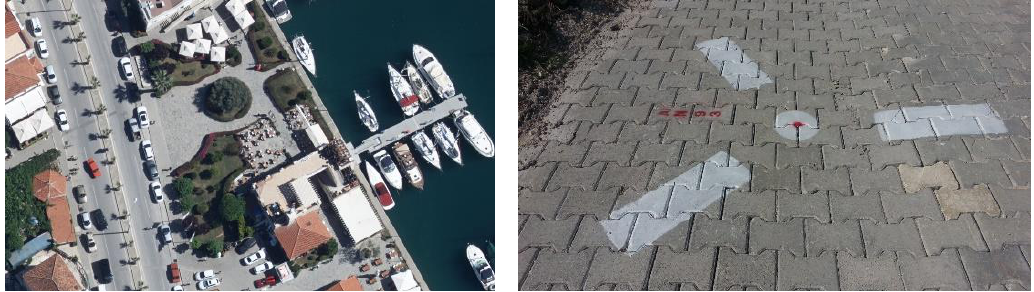
Figure 2. Level of detail in one image ( left ) and the ground signalization of one GCP ( right ).